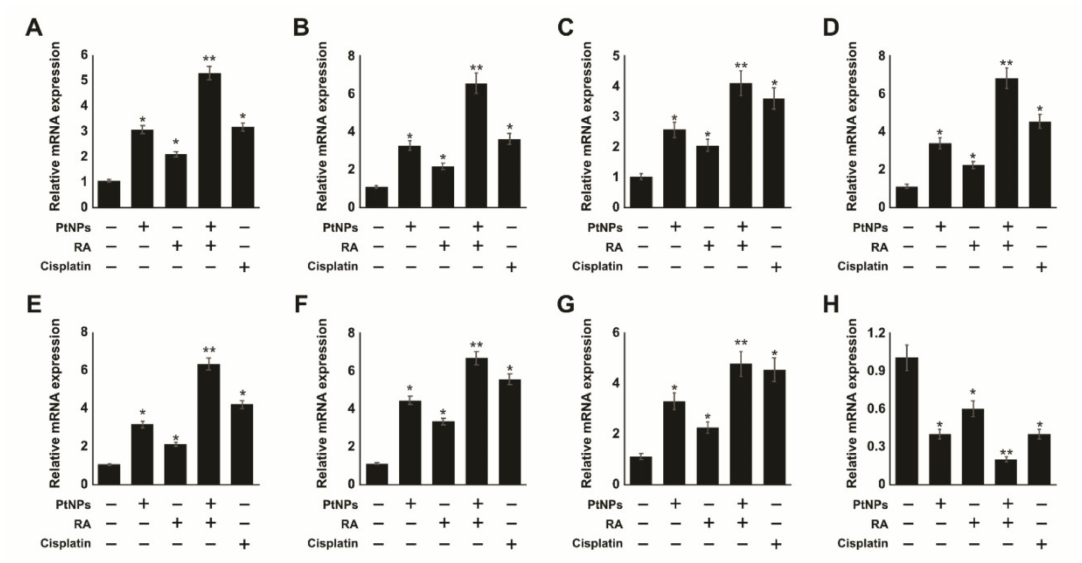
Figure 9. PtNPs and RA enhance the expression of endoplasmic reticulum stress (ERS) and apoptotic genes. SH-SY5Y cells were incubated with PtNPs (25 µ g / mL), RA (12.5 µ M), combination of PtNPs (25 µ g / mL) and RA (12.5 µ M), or cisplatin (6.5 µ M) for 24 h. The mRNA expression of ERS-related genes, IRE1 ( A ), PERK ( B ), ATF6 ( C ), and ATF4 ( D ) was analyzed using quantitative reverse-transcription polymerase chain reaction. mRNA expression of apoptotic genes, p53 ( E ), Bax ( F ), caspase-3 ( G ), and Bcl-2 ( H ). The fold change in the expression was determined relative to GAPDH expression. The results are expressed as mean fold change ± standard deviation from three independent